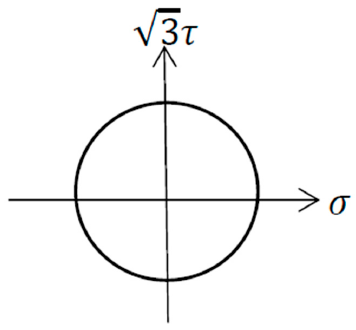
Figure 2. Axial-torsion loading path.